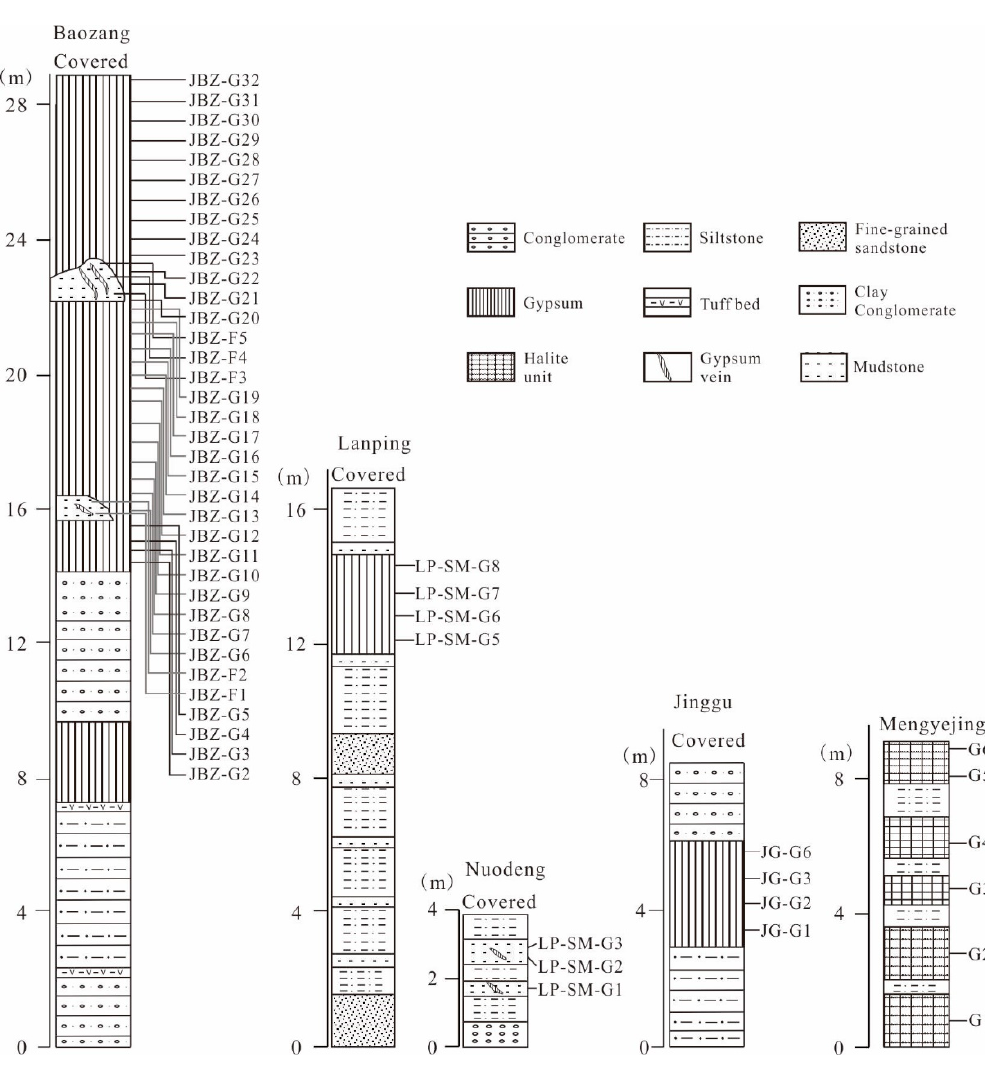
Figure 3. Sampling sections/sites from Baozang, Lanping, Nuodeng, Jinggu, and Mengyejing.